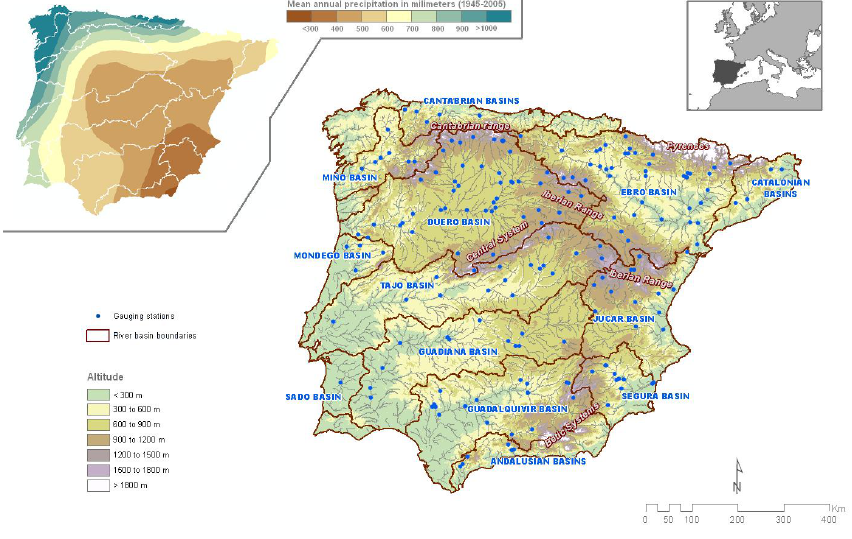
Fig. 1. The Iberian Peninsula: topography and location of the gauging stations used in the study distributed by mayor basins. Upper left corner: distribution of the mean annual precipitation for the study period (1945–2005). Upper right corner: Iberian Peninsula location